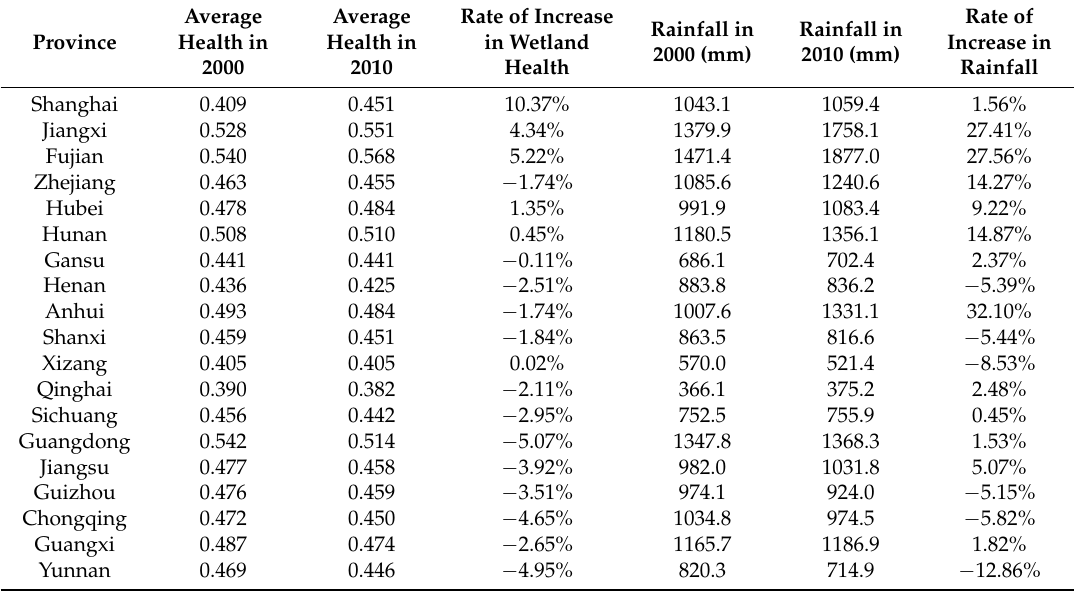
Table 5. The average health of the wetland ecosystem and rainfall in different provinces of the Yangtze River